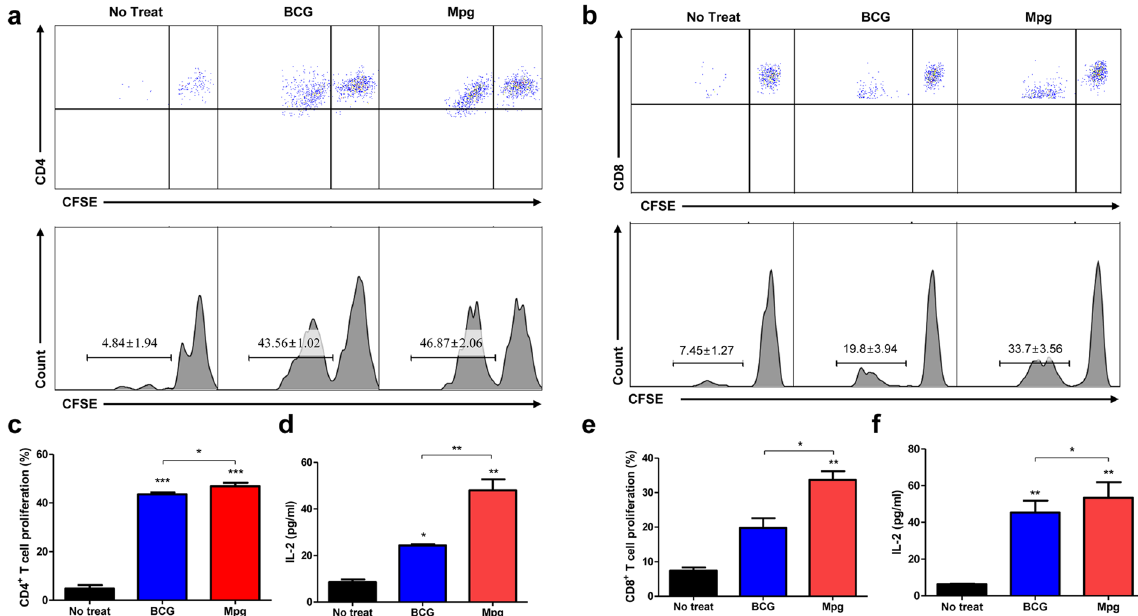
Figure 5. Enhanced T cell proliferation induced by M. paragordonae (Mpg)-infected BMDCs. Proliferation of ( a and c ) CD4 and ( b and e ) CD8 T cells induced by BCG- or Mpg-infected BMDCs was examined by CFSE dilution method and detected by flow cytometry. The data represent the mean ± standard deviation of CFSE intensities in each group ( * P < 0.05, ** P < 0.01, *** P < 0.001; Student’s t -test). ( d and f ) IL-2 cytokine amounts in the supernatants of the CD4 and CD8 T cells used for the proliferation assay were measured by ELISA ( * P < 0.05, ** P < 0.01, *** P < 0.001; Student’s t